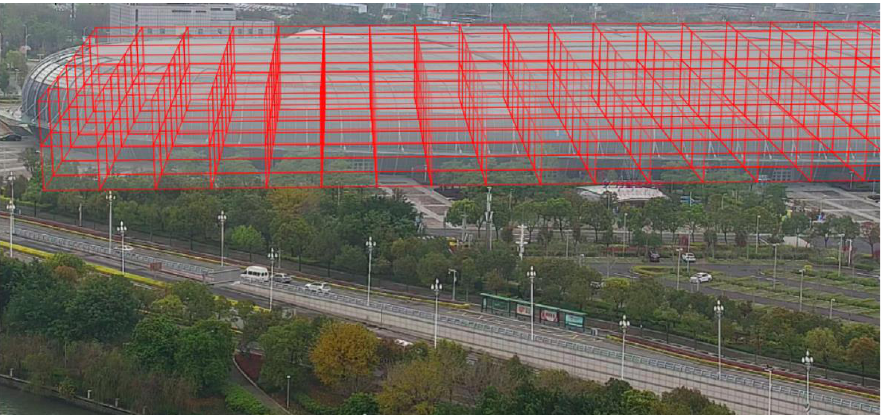
Figure 14. Construction of video stereo grid space display.